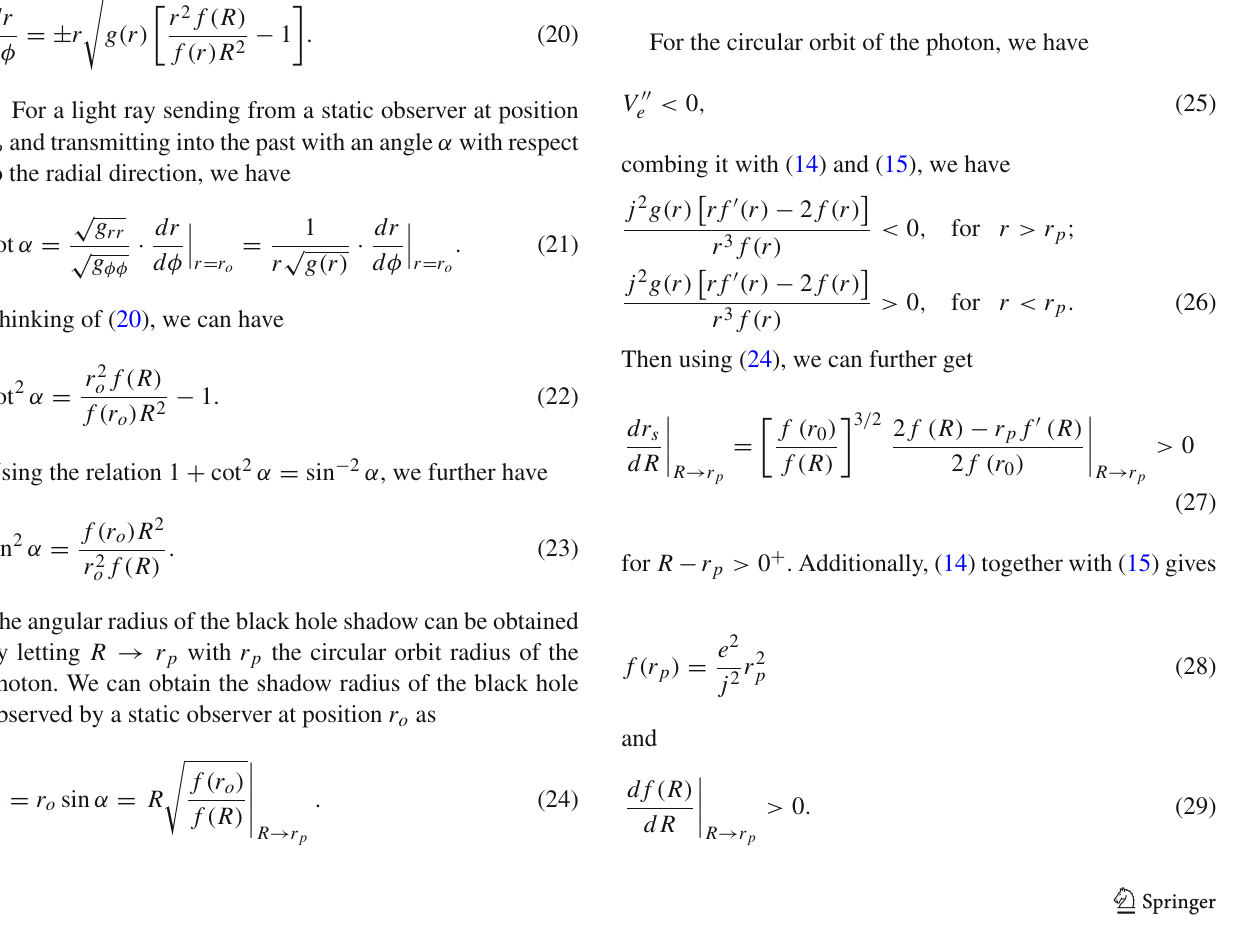
Fig. 1 The upper diagram shows the relation between the shadow radius and the event horizon for the RN-AdS black hole. The bottom diagram shows the temperature in terms of the event horizon and the shadow radius for the black hole, respectively. We set the charge of the black hole as 1 and the cosmological constant as − 4 π/ 225. The purple, red and green curves in the top diagram correspond to the curves with the same colours in the bottom diagram